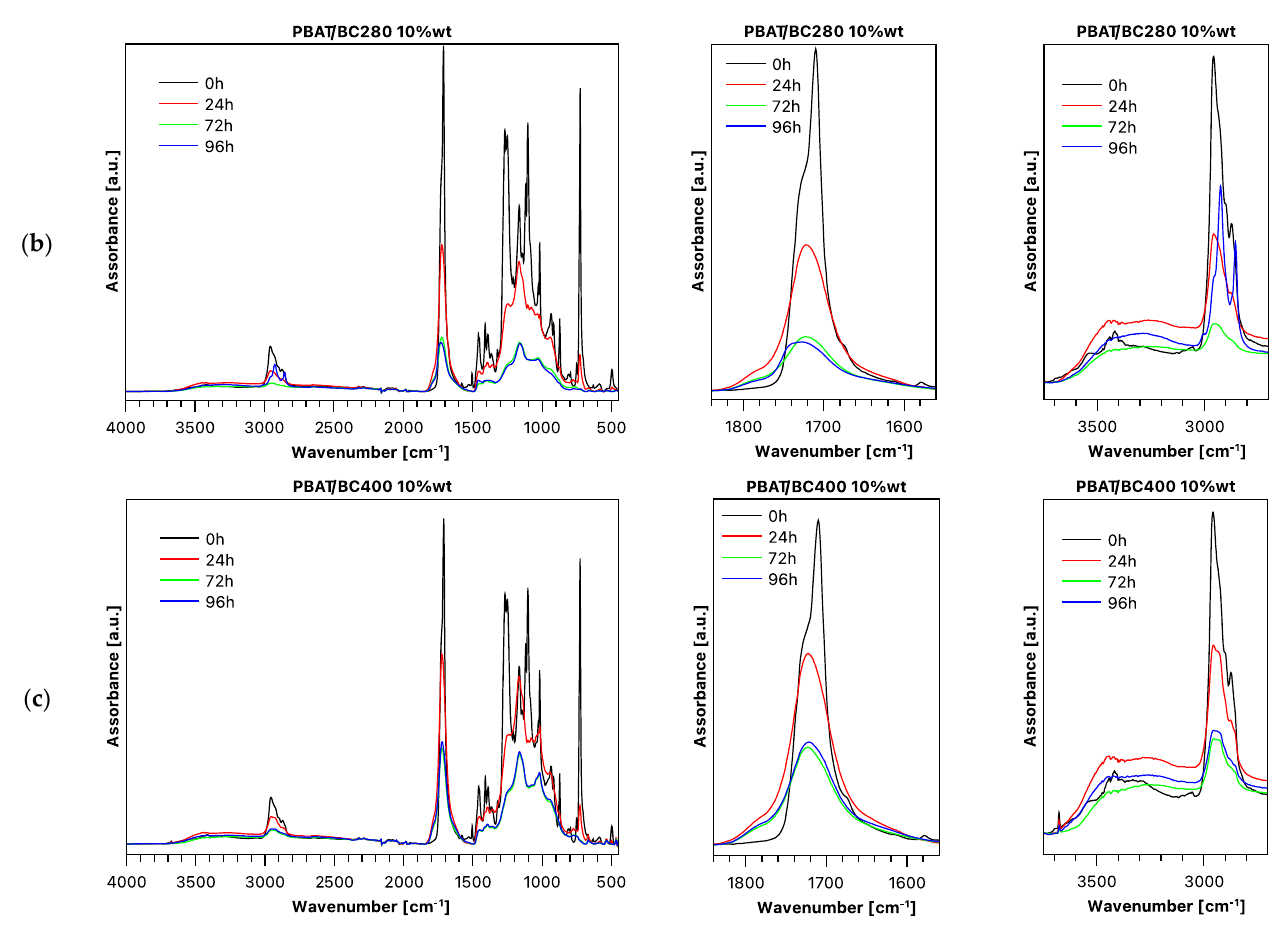
Figure 9. FT-IR spectra in ATR mode as a function of photo-oxidation time of ( a ) neat PBAT, ( b ) PB/BC280 10 wt% and ( c ) PBAT/BC400 10 wt%.